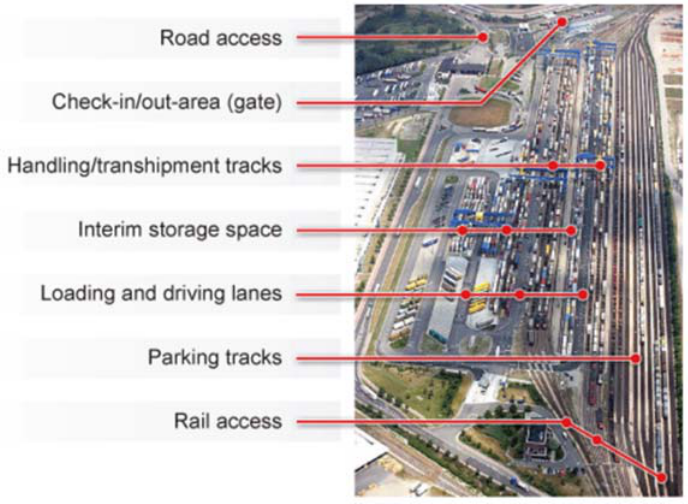
Figure 1. Typical layout of a rail-road terminal. (Source: https://www.intermodal-terminals.eu/intermodal-terminals, accessed on 6 September 2021).